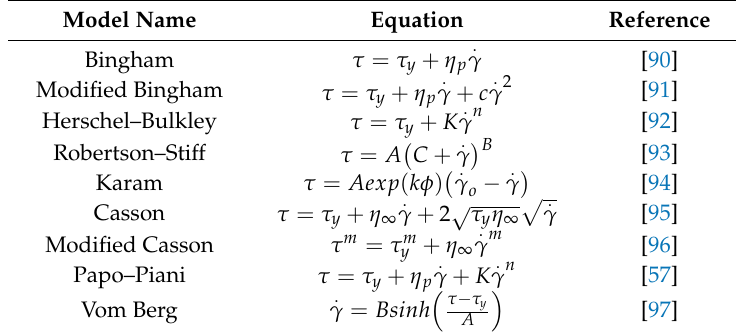
Table 1. Viscoplastic models used for describing steady flow curve of cement